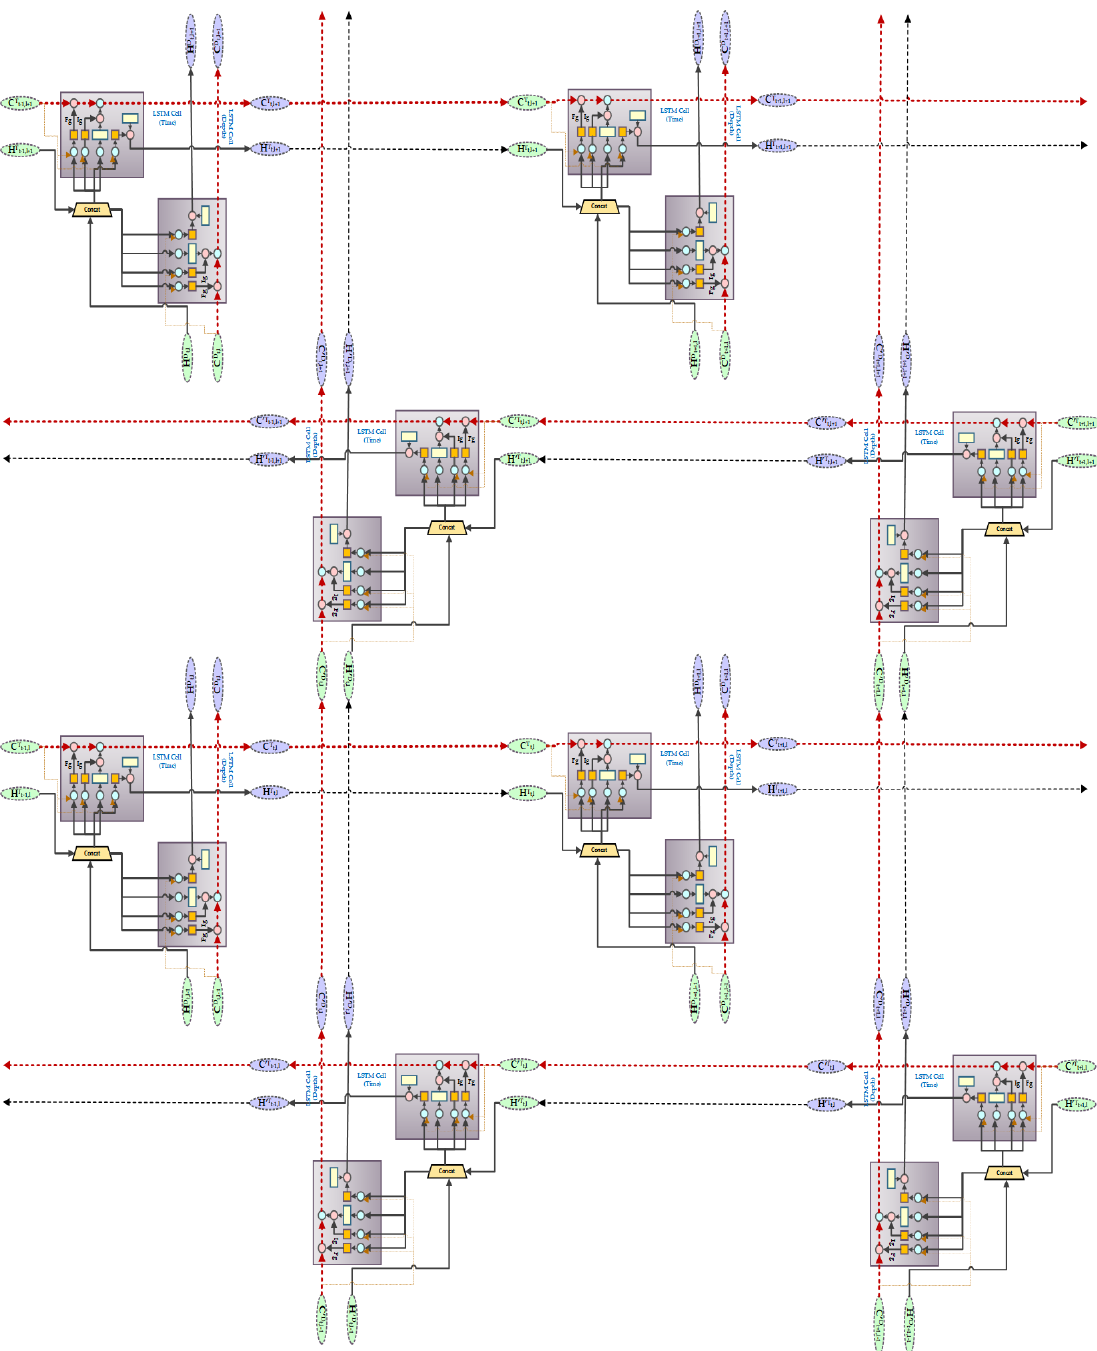
Figure 6. Bidirectional Grid Lon Short-Term Memory (BiGridLSTM)